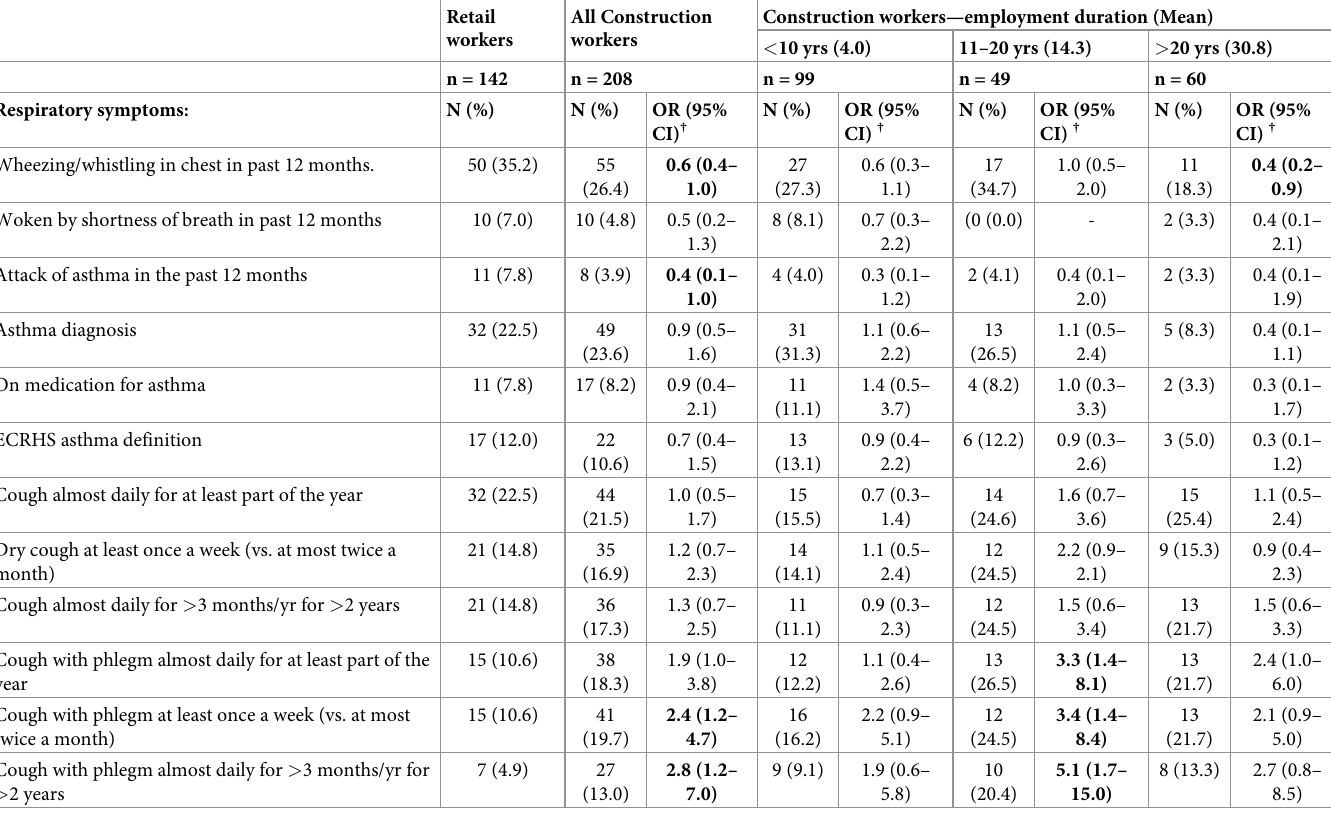
Table 2. Prevalence odds ratios (OR) of respiratory symptoms in all construction workers and stratified by employment duration tertiles compared to reference workers. Retail